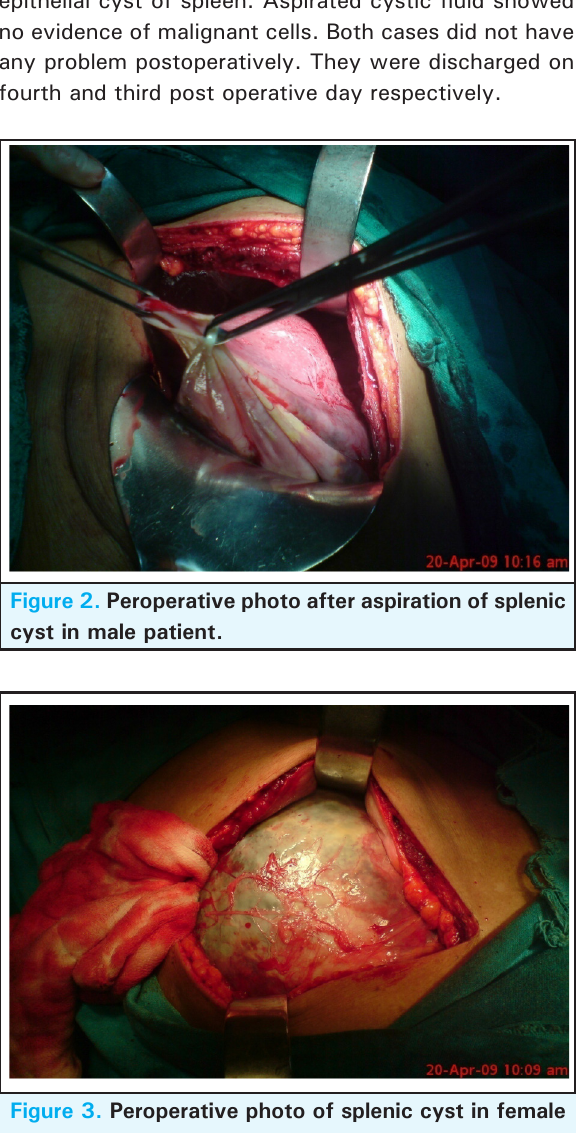
Figure 3. Peroperative photo of splenic cyst in female